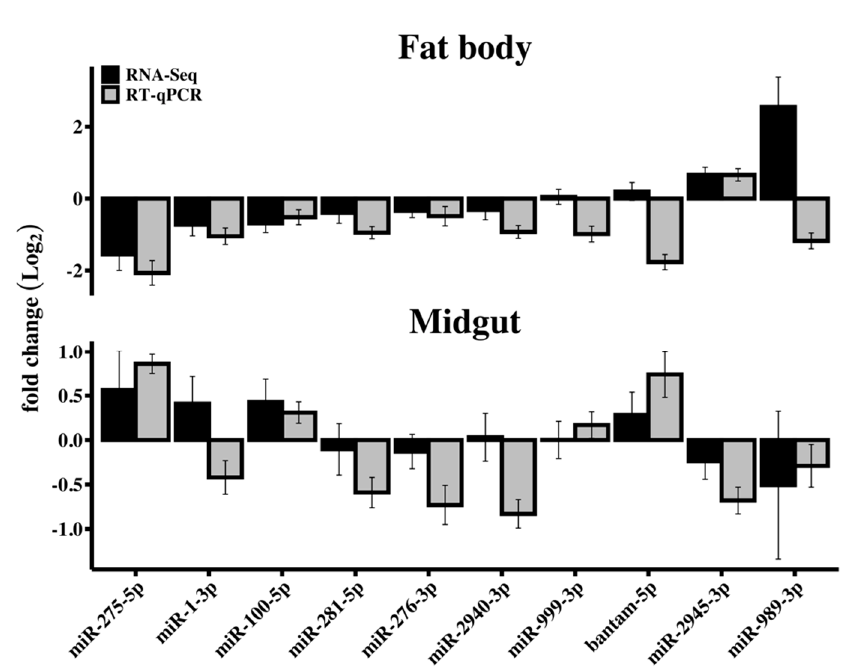
Figure 6. RRV induced di ff erential expression of Ae. aegypti miRNAs. Contrasting RNA-Seq and RT-qPCR measurement of RRV-induced di ff erential expression of 10 miRNAs in Ae. aegypti fat body and midgut RNA samples at 2 dpi. Error bars represent the standard error of the mean of the biological replicates ( N = 3).